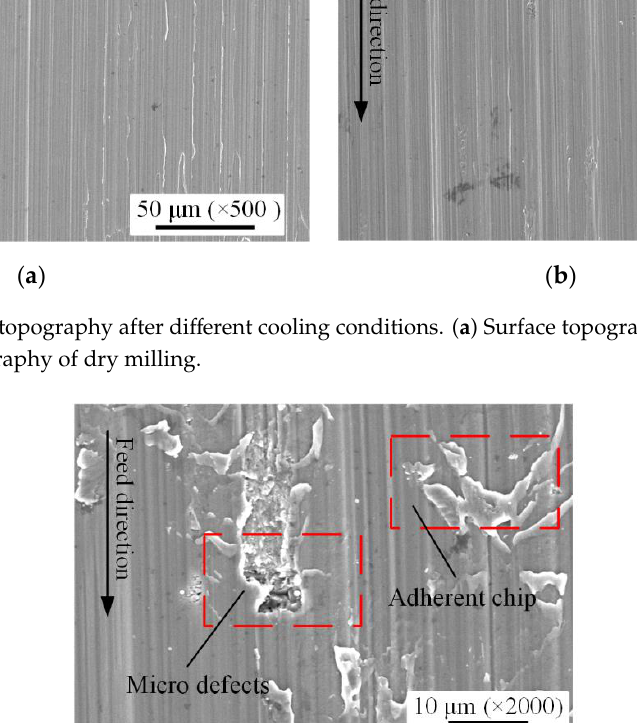
Figure 5. Surface topography after different cooling conditions. ( a ) Surface topography of wet milling, ( b ) Surface topography of dry milling.